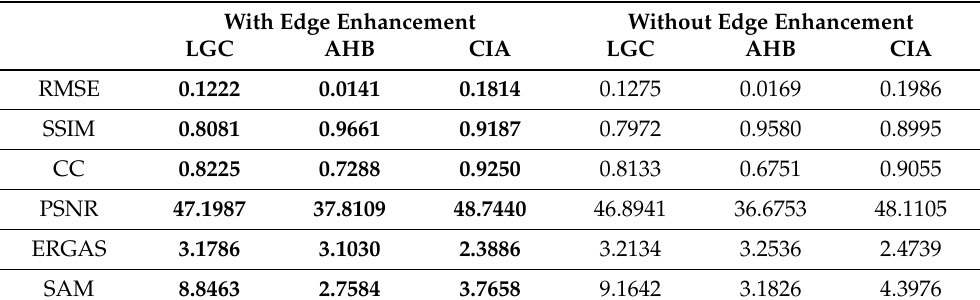
Table 4. Evaluation metrics on the results of ablation experiments of edge enhancement on different datasets. Bold values indicate the best